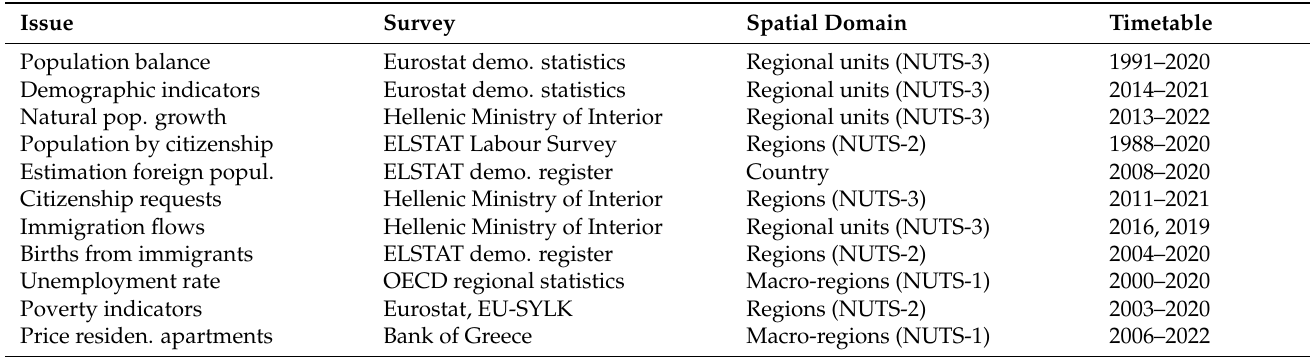
Table 1. A summary of official statistics considered in this